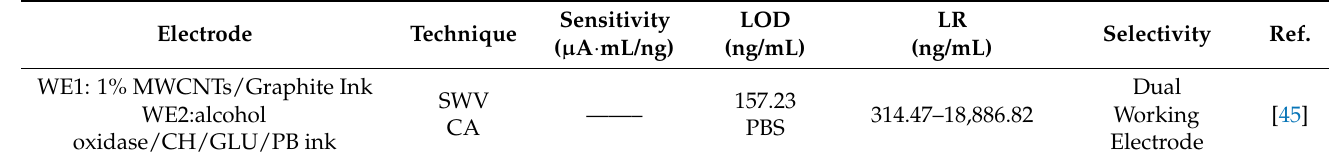
Table 4. An MWCNTs-modified ring electrochemical sensor for detecting ∆ 9 -THC was developed, along with its sensing characteristics and working-functional